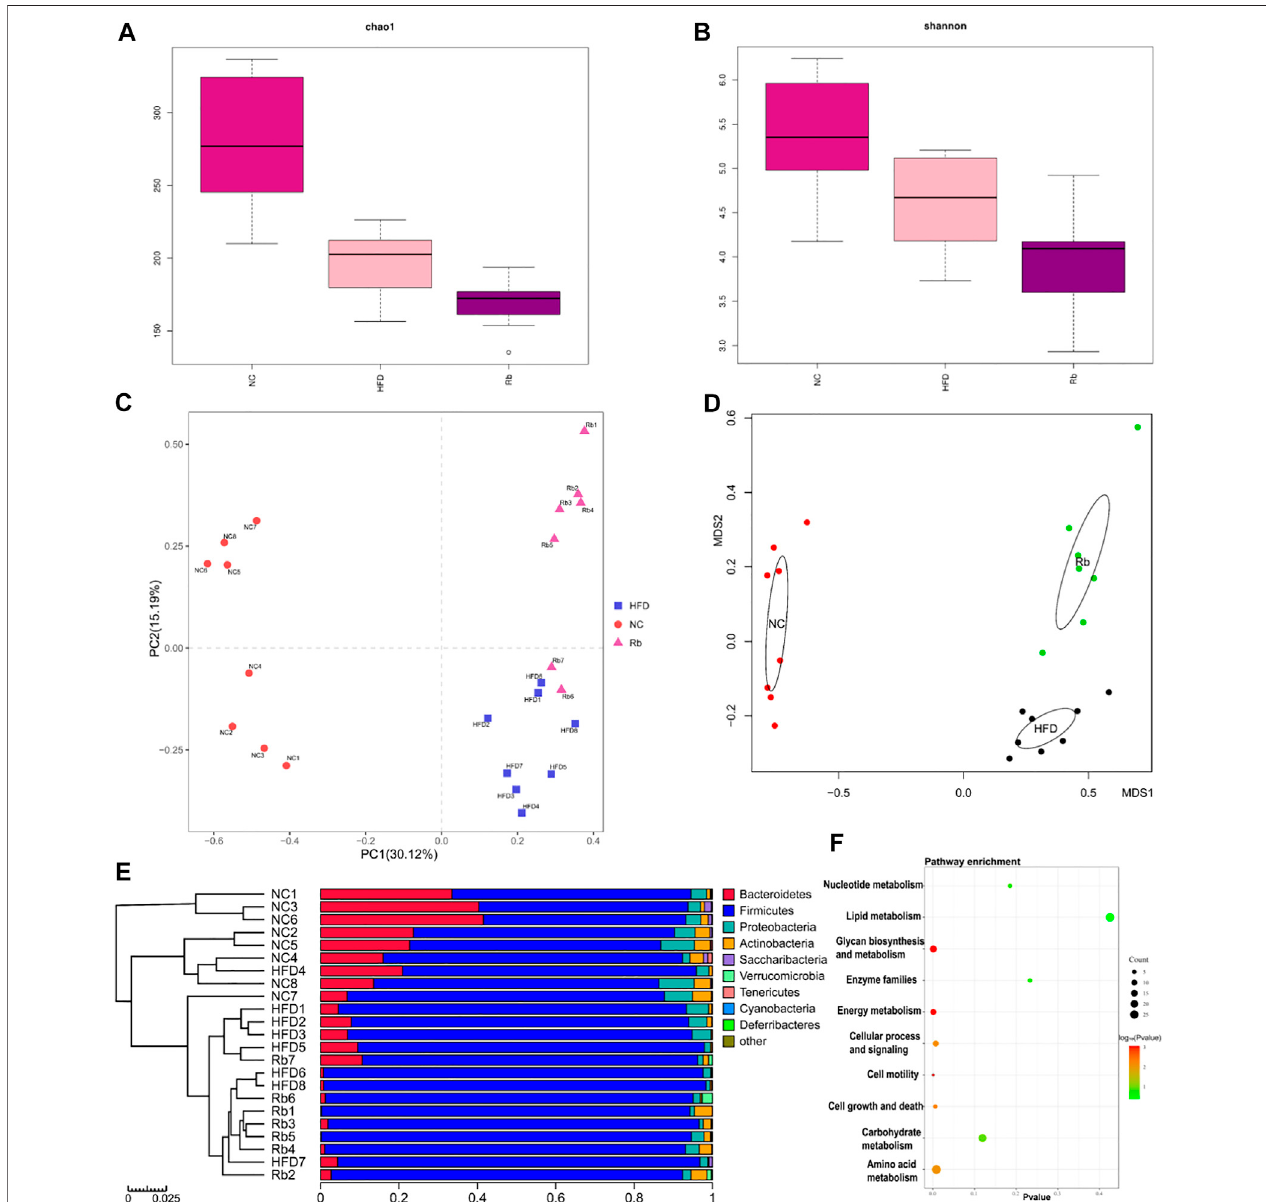
FIGURE 4 | 16S rRNA analysis. Faeces were harvested at the end of all experiments, gut microbiota analysis was performed. Alpha diversity analysis of (A) chao1 index; and (B) Shannonindex; Beta diversity analysisof (C) Principal component analysis(PCA); and (D) Non-metricmultidimensional scaling (NMDS) plots. (E) Relative abundance of different classes. (F) PICRUSt function prediction of the different abundance of gut microbiota in NC, HFD, and Rb1 group (Welch ’ s t test, two-sided).